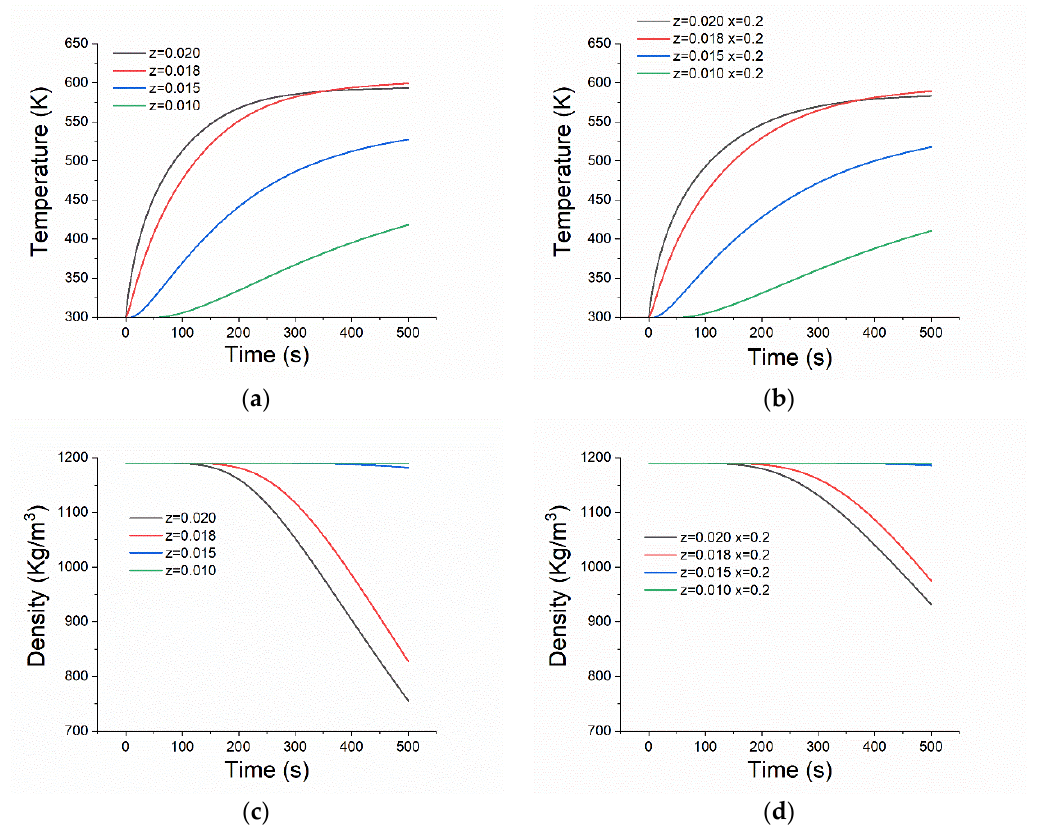
Figure 3. Transient temperature and density histories at different locations. ( a ) Temperature history at x=0; ( b ) Temperature history at x=0.2; ( c ) Density history at x=0; ( d ) Density history at x=0.2.